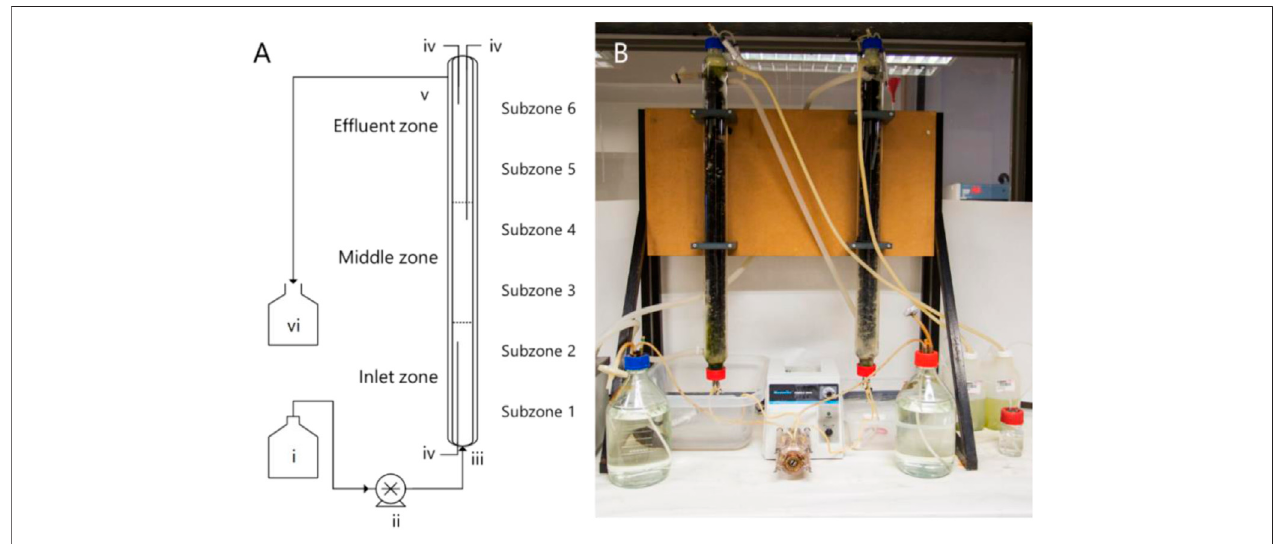
FIGURE 1 | (A) Schematic diagram and (B) photograph of the UAPBRs operated in this study, labelled with the layout of the demarcated zones and the (i) feed reservoir, (ii) peristaltic pump, (iii) inlet port and (iv) sampling ports. The reactors were discharged by gravity via the (v) ef fl uent port and waste collected in